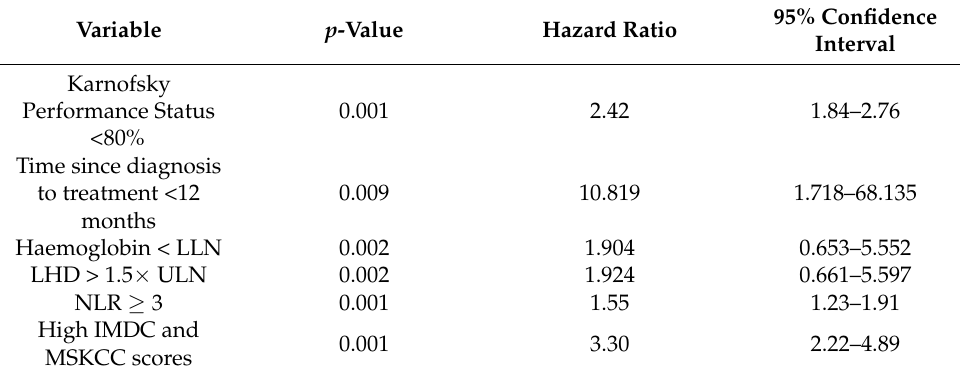
Table 2. Univariate analysis.